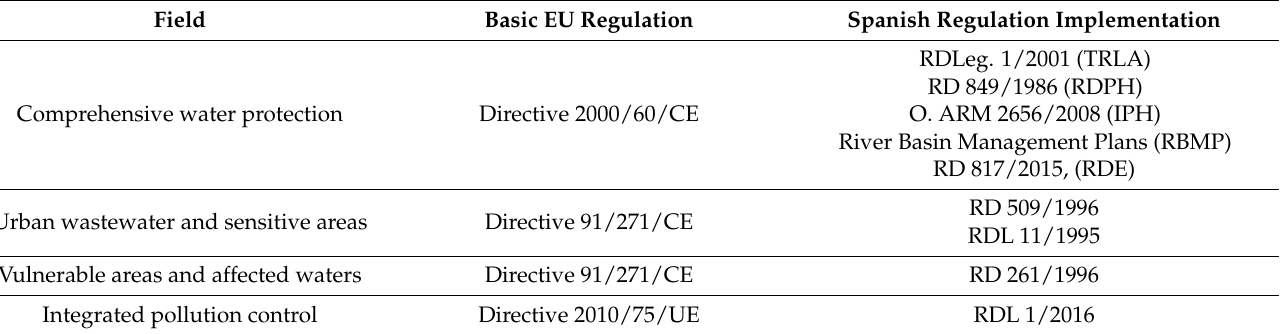
Table 3. European Union regulation and its implementation in